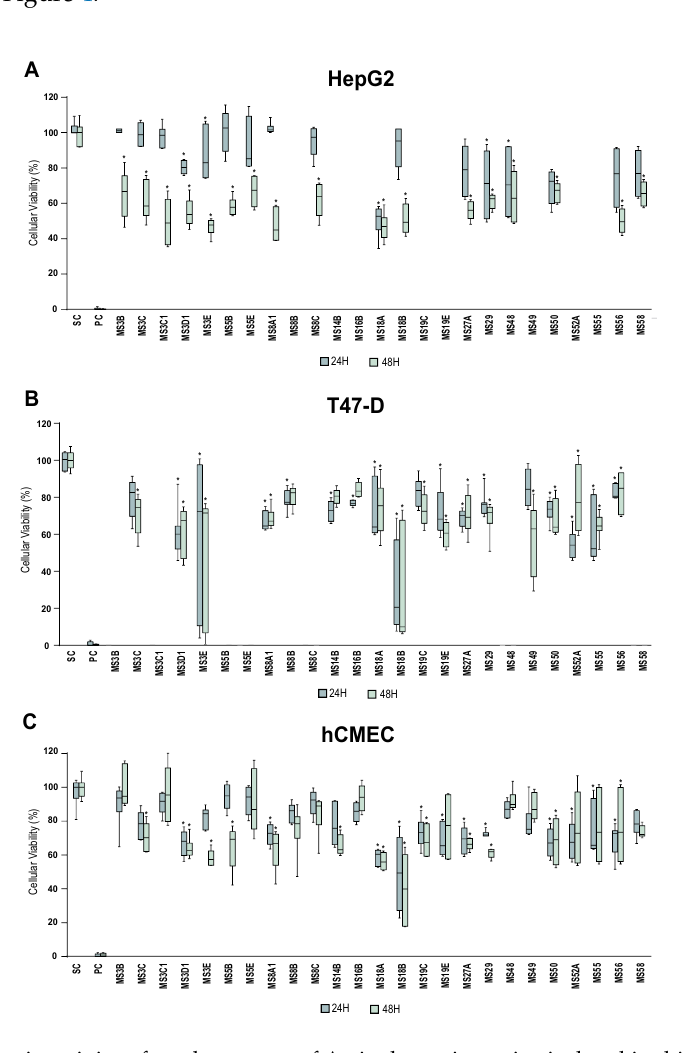
Figure 3. Cytotoxic activity of crude extracts of Actinobacteria strains isolated in this study, tested at 3.0 mg mL − 1 . The e ff ects on the cellular viability of ( A ) liver cancer HepG2 and ( B ) breast carcinoma T-47D cancer cell lines, and ( C ) a nontumor hCMEC / D3 cell line (human brain capillary endothelial cells) are shown after 24 and 48 h of exposure The graphs relative to T47D and HepG2 cell lines only show extracts with significant di ff erences. PC and SC denote positive and solvent controls, respectively. Values are presented as mean ± standard deviation from two independent assays conducted in triplicate and significant di ff erences compared to the solvent control are annotated with asterisks in the graphs (* p <